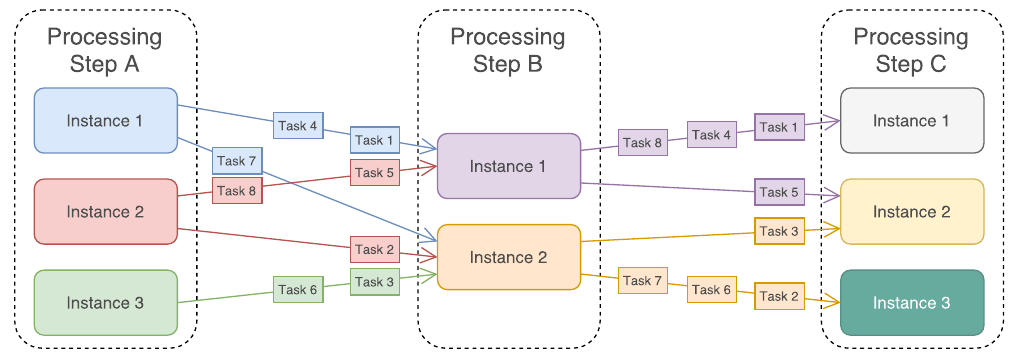
Figure 1. Flow of tasks through a processing